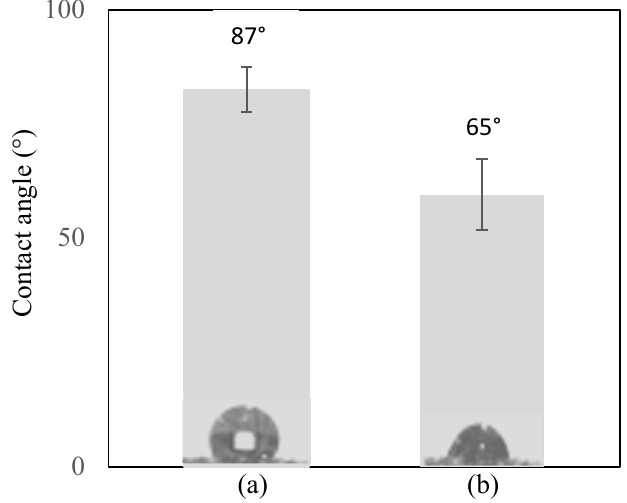
Figure 3. Contact angle values of ( a ) untreated cotton and ( b ) plasma treated cotton.